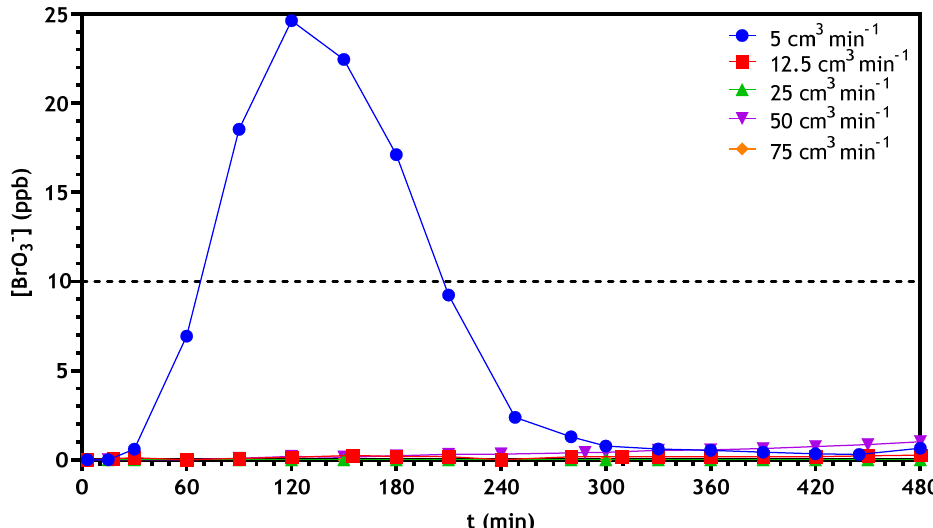
Figure 4. Bromate concentration (ppb) during continuous hydrogen reduction over the catalyst 1 wt.% Pd/MWCNT-O mixed with 0.500 mm carborundum under different H 2 flow rates. (Q = 5 mL min − 1 , 200 mg CAT , C (BrO 3 − ) = 200 ppb).